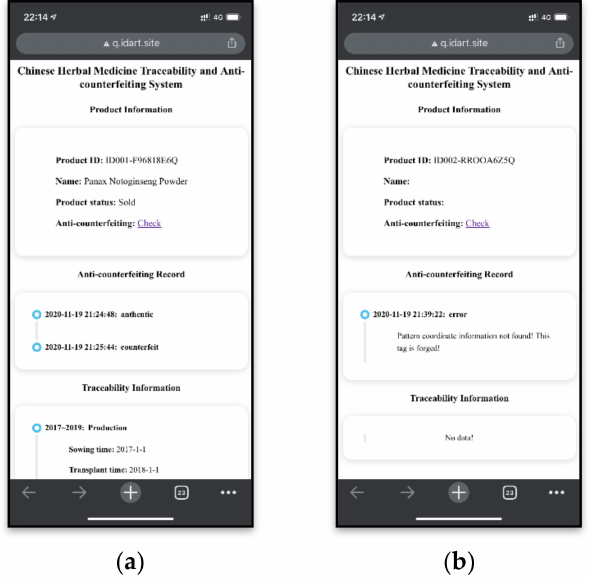
Figure 16. Anti-counterfeiting records in traceability information query web page. ( a , b ) Anti- counterfeiting records for the authentic (or counterfeit) tags and forged tag, respectively.